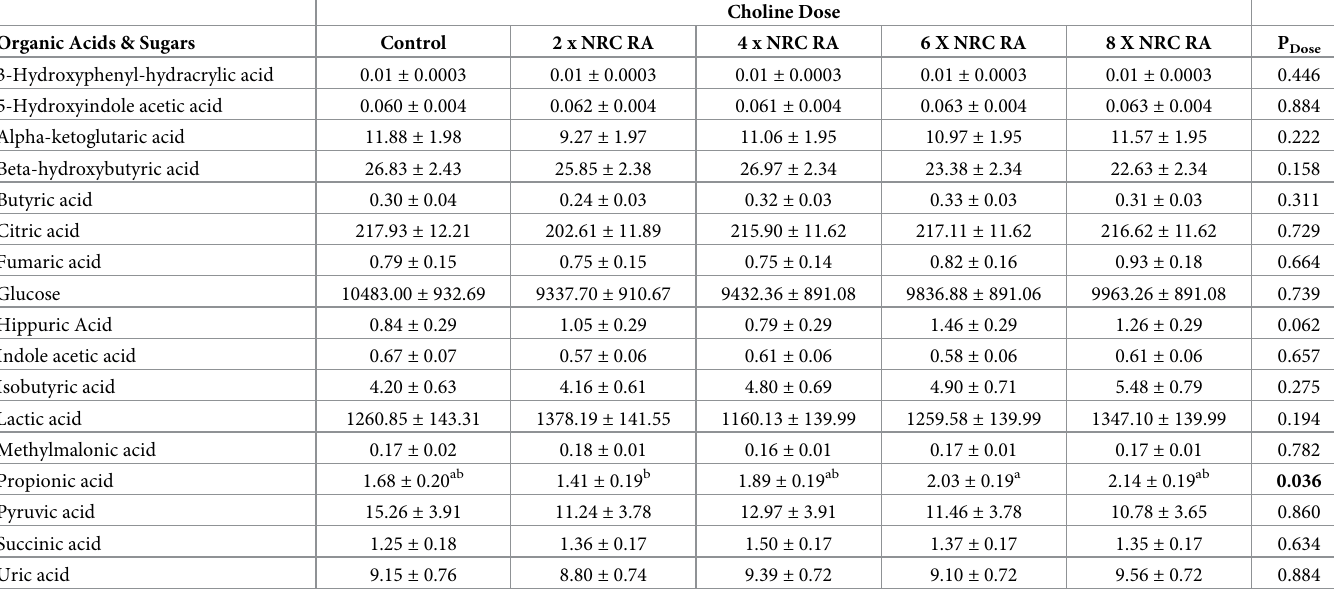
Table 8. Mean serum concentrations ( μ M) of organic acids and sugars determined by DI-MS in overweight cats (n = 14) receiving control (no additional choline supplementation, 1.2 x NRC RA, 77 mg/kg BW 0.67 ), choline at 2 x NRC RA (126 mg/kg BW 0.67 ), 4 x NRC RA (252 mg/kg BW 0.67 ), 6 x NRC RA (378 mg/kg BW 0.67 ), and 8 x NRC RA (504 mg/kg BW 0.67 ), in a 5 x 5 Latin square design for 3-week